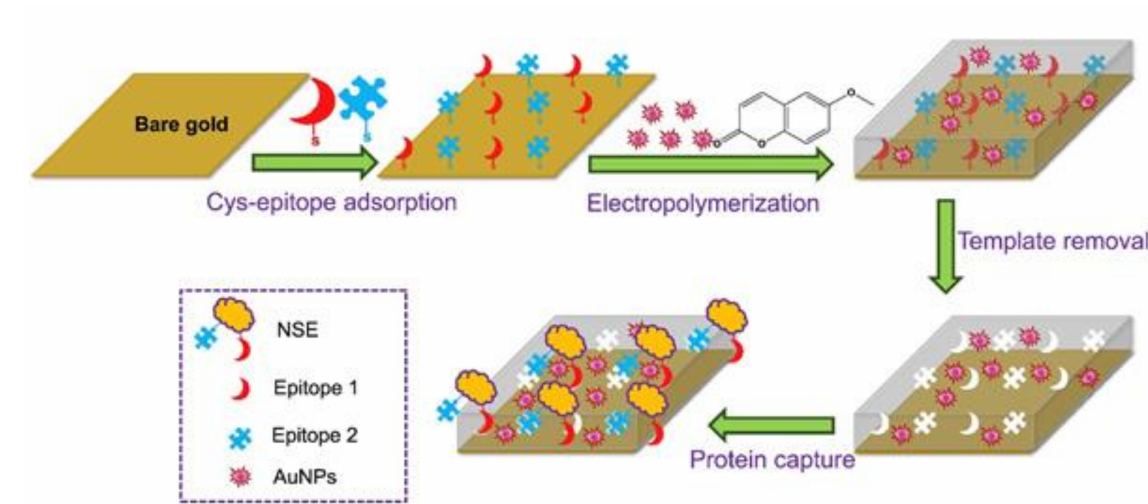
Figure 2. The principle of protein detection using the AuNP-decorated hybrid MIP sensor, which was fabricated by electropolymerization technique in the presence of two different NSE epitopes and AuNPs, reprinted with permission from [28], ©